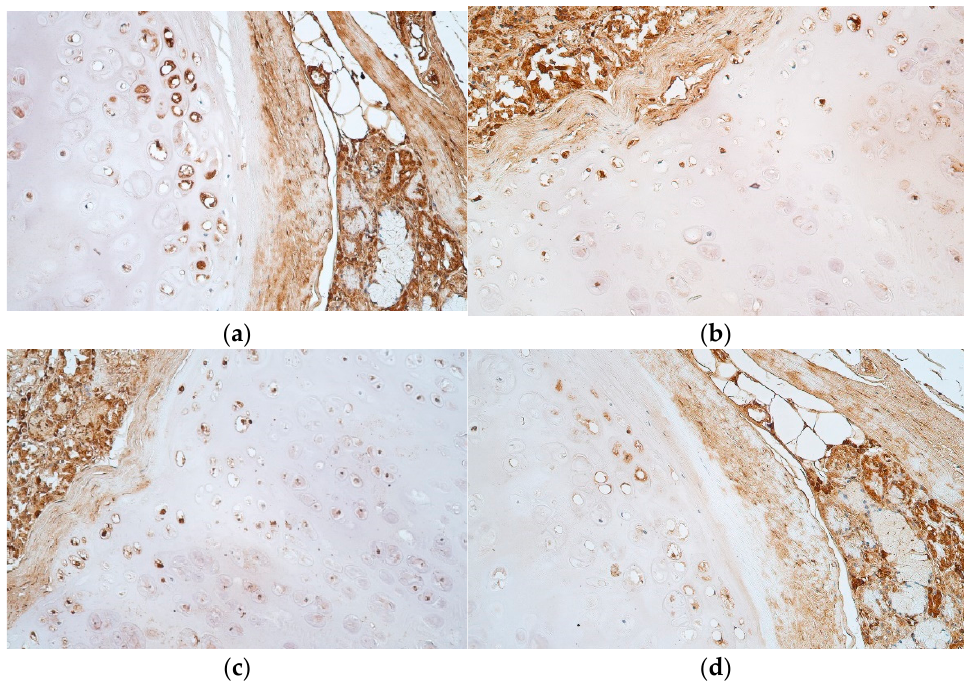
Figure 4. ( a – d ) Immunohistochemical micrographs of tracheal hyaline cartilage: ( a ) Moderate number of IL-10 positive cells in proliferation and growth zones. IL-10 IMH, ×200; ( b ) A moderate number of IL-10 positive cells across the proliferation zone. IL-10 IMH, ×200; ( c ) Moderate number of LL-37 positive cells across proliferation and growth zones. LL-37 IMH, ×200; ( d ) Note the moderate number of LL-37 positive cells in the growth zone. LL-37 IMH, ×200.